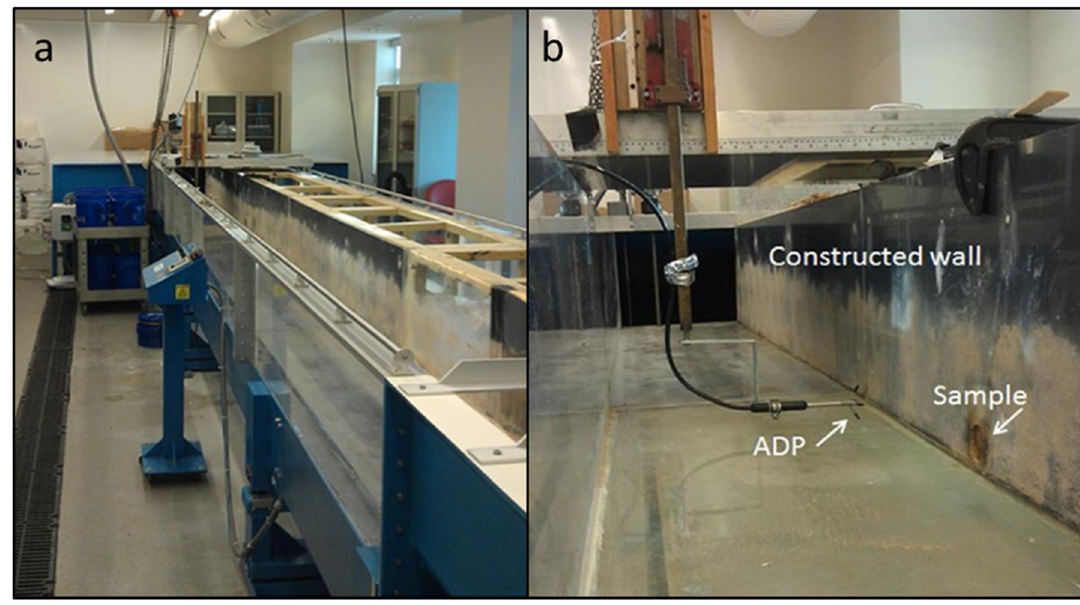
Figure 2. ( a ) Flume channel and ( b ) close-up of sample location. Table 1. Flume settings used for each test condition.